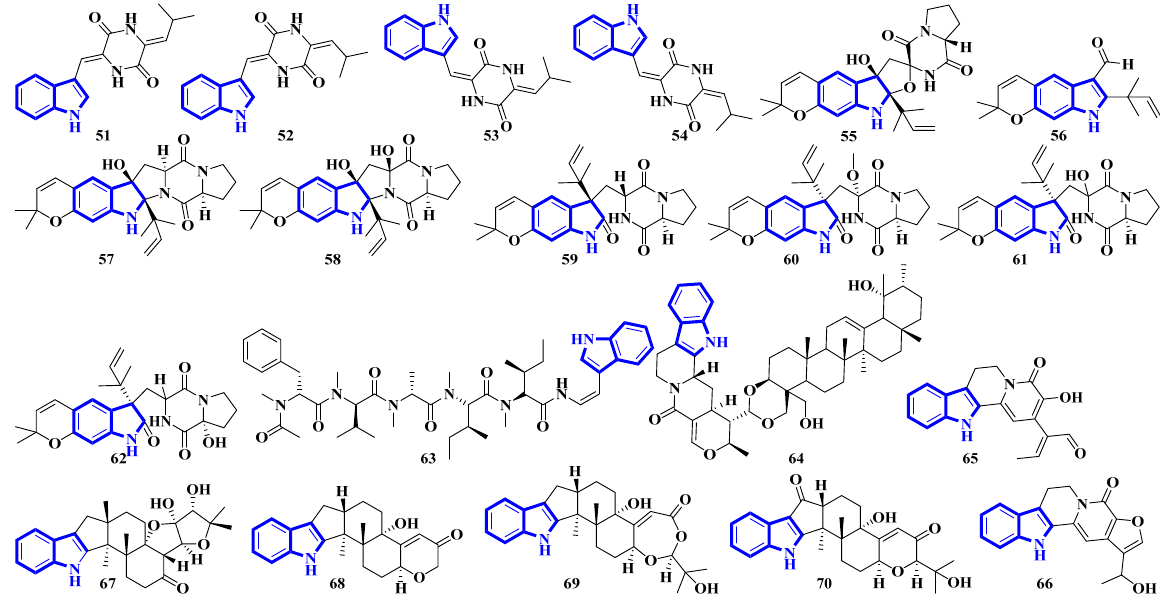
Figure 5. Novel indole alkaloids 51 to 70 .